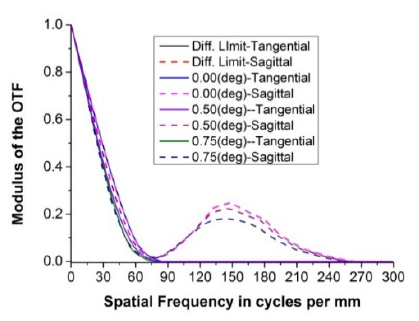
Figure 10. The MTF of the Golay3 MMT.